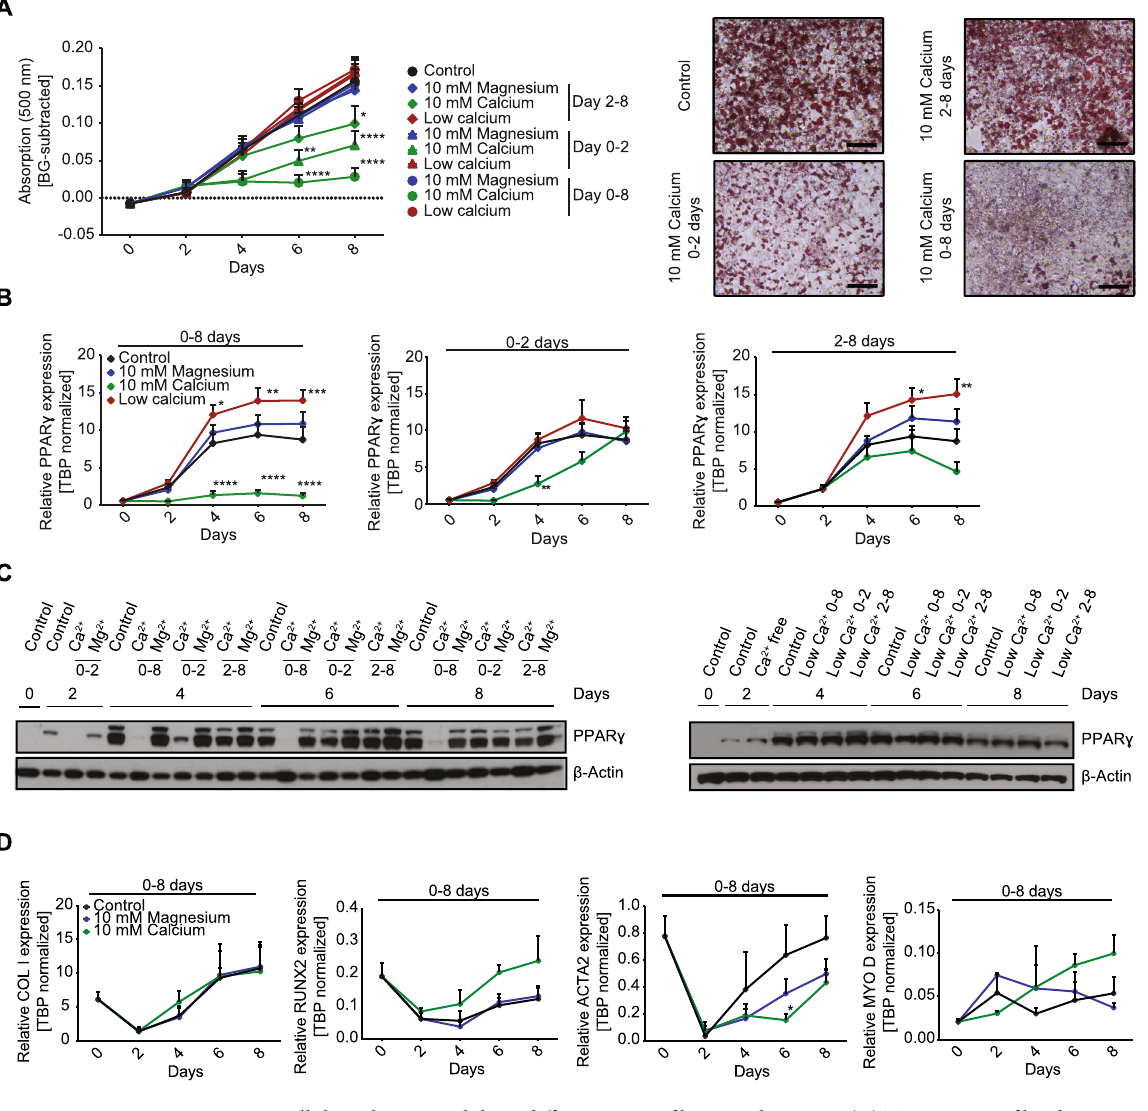
Figure 1. Extracellular calcium modulates differentiation of brown adipocytes. ( A ) Time course of lipid content of in vitro differentiated brown adipocytes. Cells were treated with 1.8 mM (control), 10 mM magnesium, 10 mM calcium or calcium free medium for either 8 days (day 0–8), only during induction (day 0–2), or after induction (day 2–8). Shown are background subtracted lipid contents, measured by Oil Red O (500 nm) (n = 6) and representative images of stained cells at day 8 after control or 10 mM calcium treatment. (size bar = 20 µ m). ( B ) PPAR γ expression normalized on TBP during an eight-day time course under the conditions as above (n = 5). ( C ) Western Blot for PPAR γ and β -Actin during the eight- day time course of differentiation with normal 1.8 mM calcium (control), 10 mM calcium (Ca 2 + ), 10 mM magnesium (Mg 2 + ) and calcium free medium during indicated time points. ( D ) Gene expression of osteogenic markers ColI and Runx2 as well as muscle markers ACTA2 and MyoD normalized on TBP during the eight- day time course of differentiation under indicated conditions (n = 3). For ( A , B and D ) data are shown as mean ± SEM. Two-way ANOVA with Dunnett’s posthoc test ( A , B ) and Tukey’s posthoc test ( D ); * p < 0.05, ** p < 0.01, *** p < 0.001, **** p < 0.0001. Full Western Blot images are provided in the Supplemental